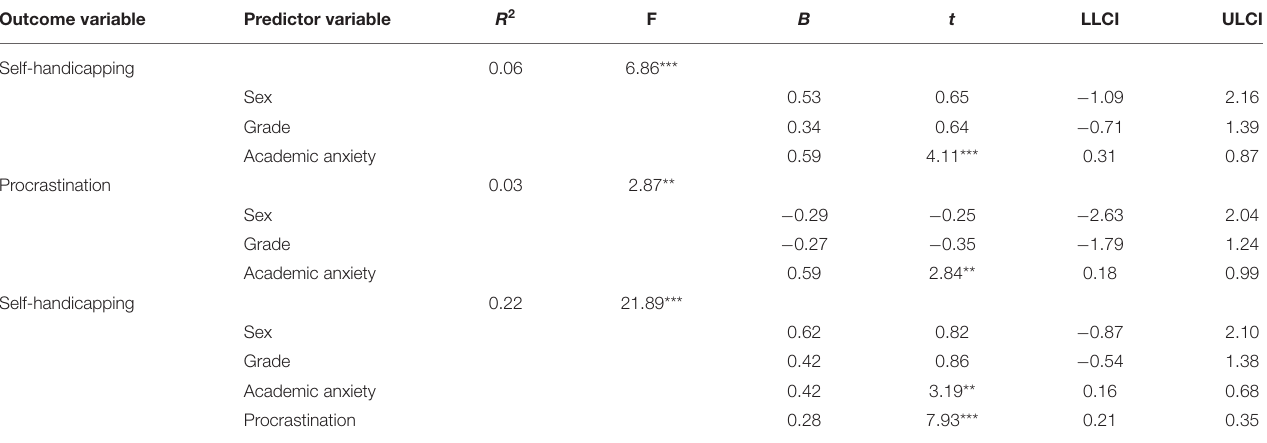
TABLE 2 | The mediation model of